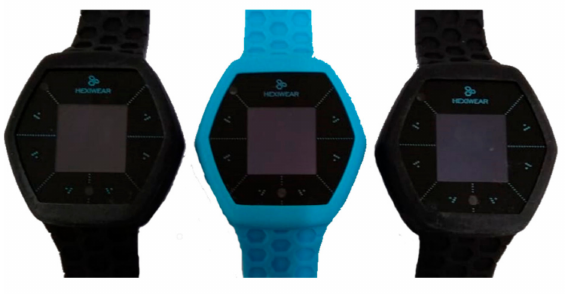
Figure 2. Hexiwear biometric